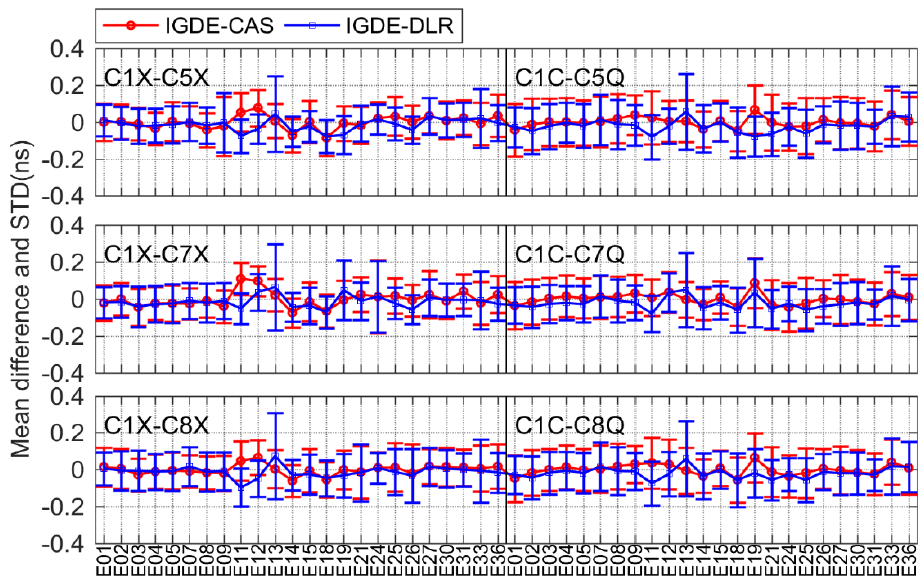
Figure 10. Mean difference and STD of GAILEO DCB between IGDE and MGEX products.